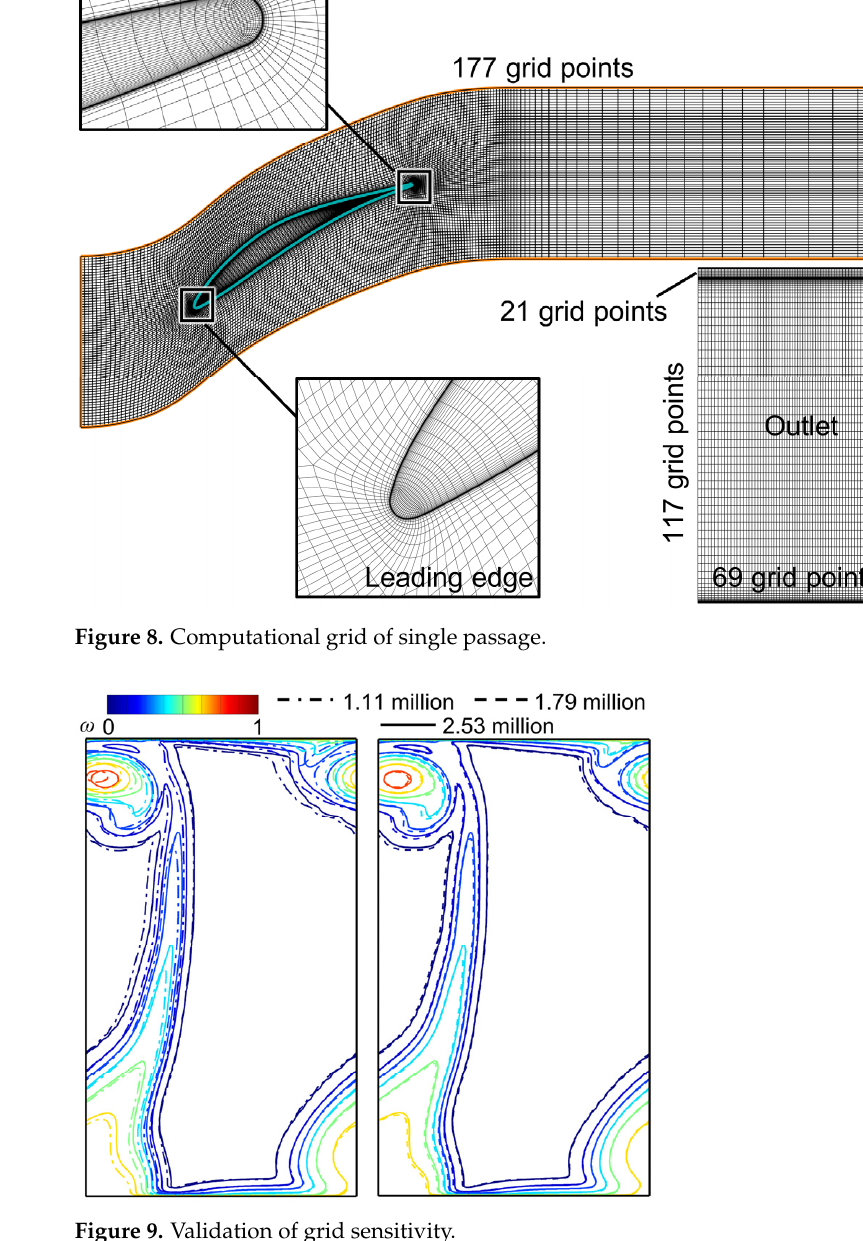
Figure 9. Validation of grid sensitivity.